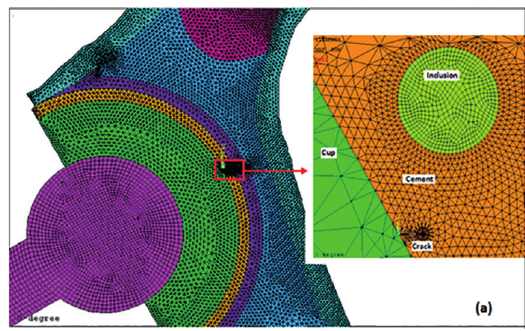
Figure 15: Typical mesh model near the inclusion and the crack.